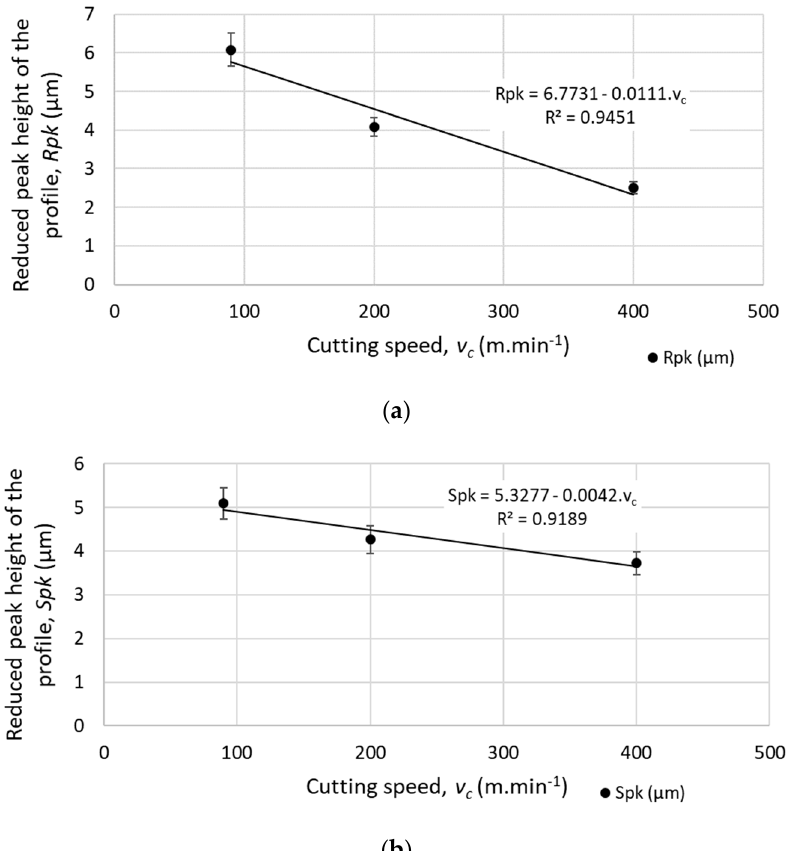
Figure 13. Mean height of peaks above the core material for different cutting speeds (at feed per tooth f z = 0.05 mm) ( a ) Rpk - mean height of peaks above the core material for a profile; ( b ) Spk - mean height of peaks above the core material for a selected area.